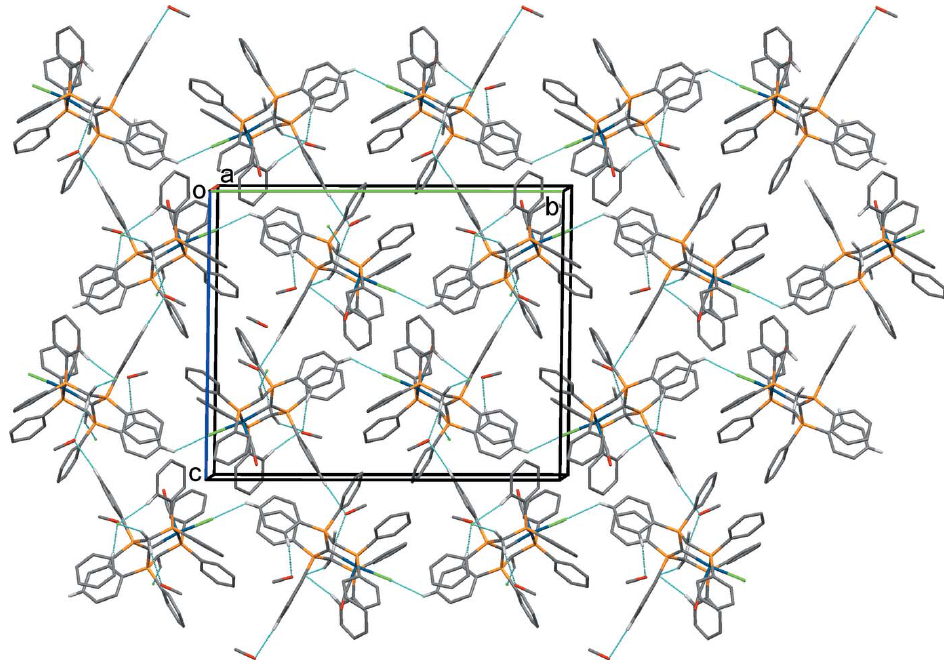
Figure 8 A view along the a axis of the crystal packing of compound 4 . Only the H atoms involved in the most significant intermolecular interactions (Table 5) have been included.